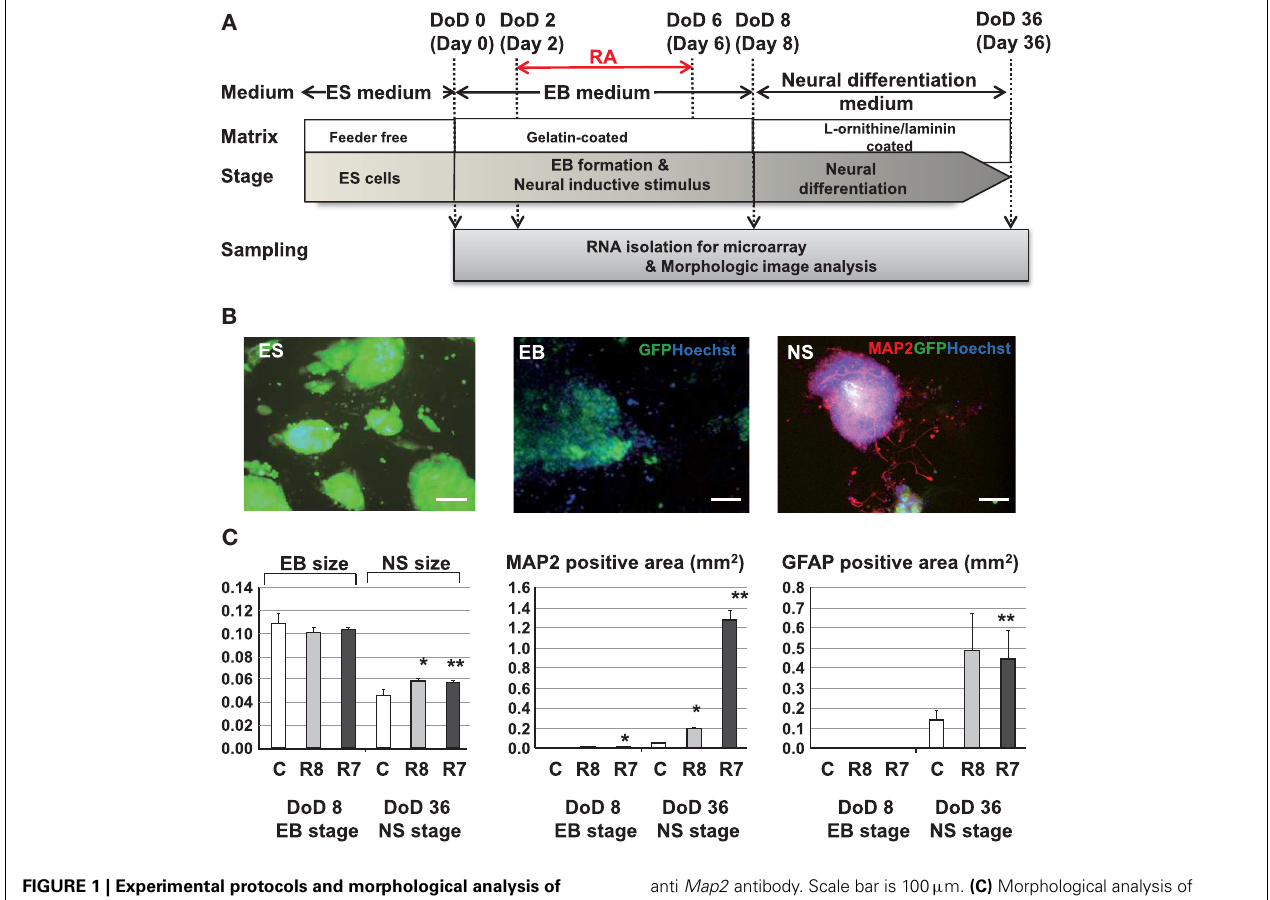
FIGURE 1 | Experimental protocols and morphological analysis of the effect of RA on the neural differentiation of mESCs. (A) A Schematic diagram of cell cultures and chemical exposures. (B) Pictures of mESCs, EBs, and neurospheres (NS) with neurite growth derived from neurosphere in fluorescent fields. Green, blue, and red fluorescent images indicate GFP of cytoskeleton proteins, nuclei stained with Hoechst and neuronal cells and neurites stained with the